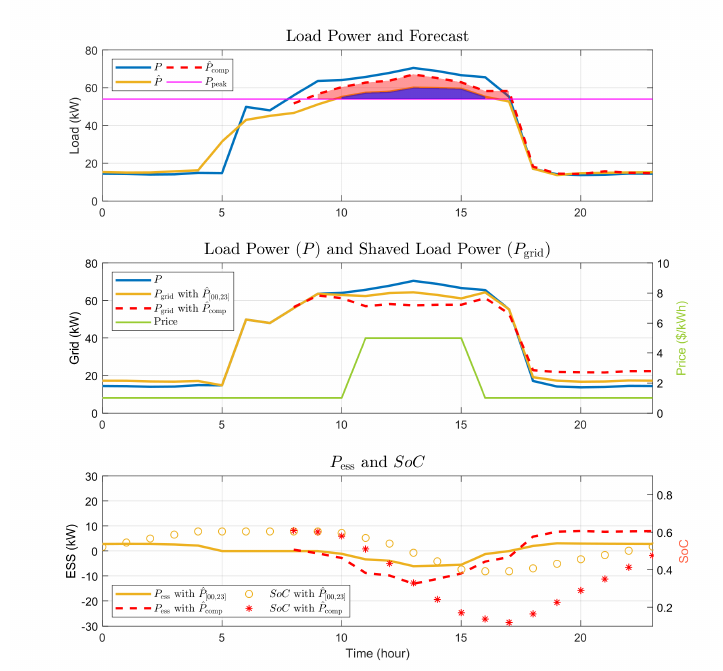
Figure 21. Result for Case 2. Little peak shaving and little charging and